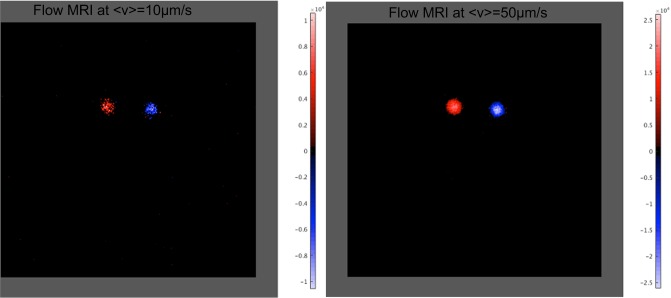
Flip-flop flow-MRI.Right figure: at 10μm/s and left figure: 50μm/s. The following parameters were used: TR = 1.2s, TE = 15ms, FOVREAD = 40mm, FOVPHASE = 40mm, NREAD = NPHASE = 256, Thk = 0.5mm, 2 slices, AVG = 2 and Tacq = 2 × 10min14.